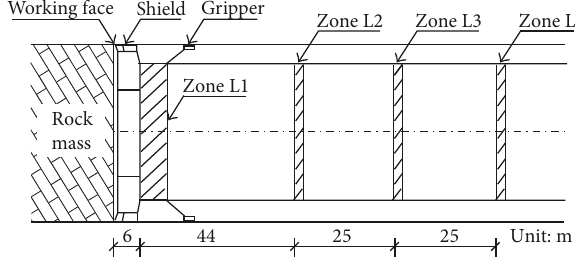
Figure 6: Layout of the support system in the TBM.